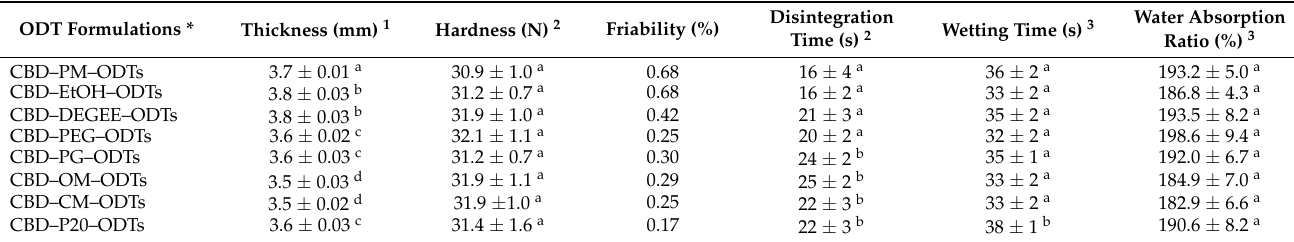
Table 3. Influence of liquid vehicle on tablet properties and wettability of CBD